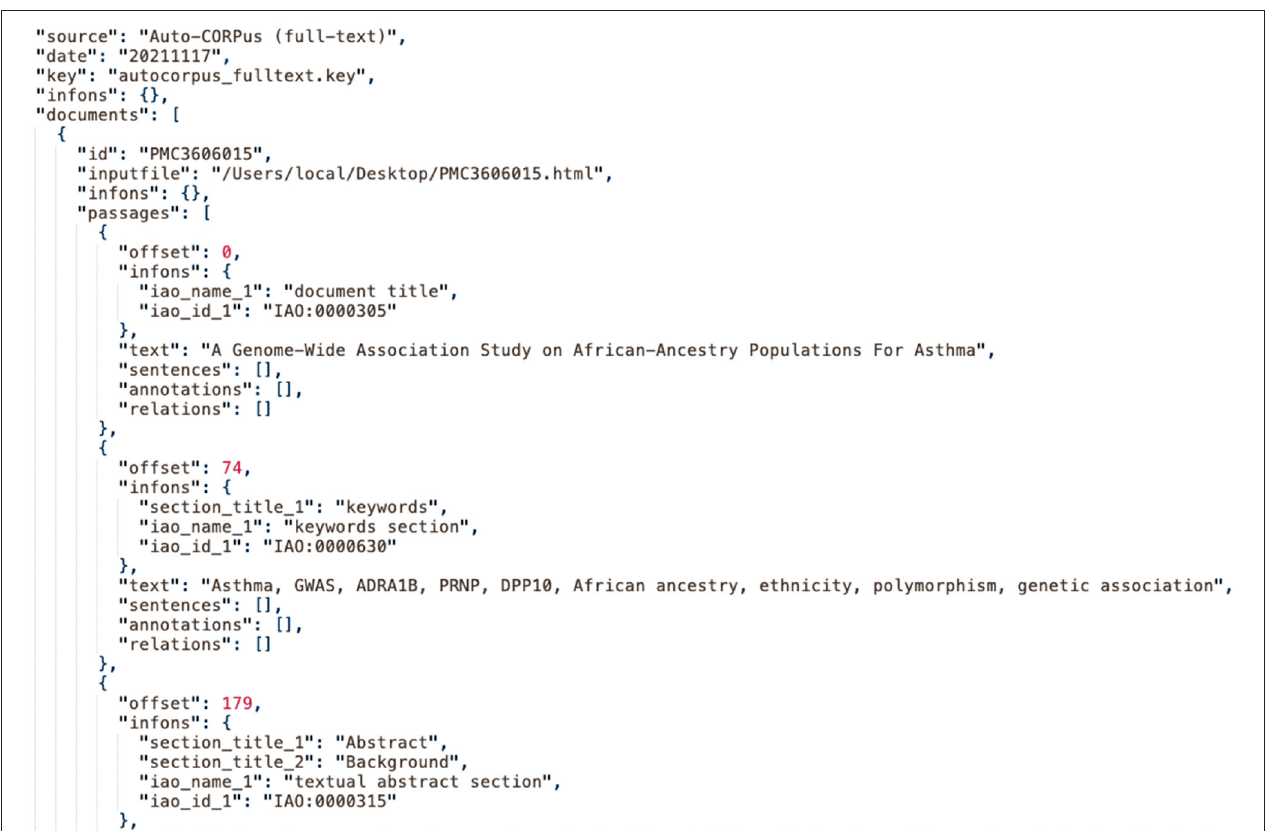
FIGURE 1 | An extract of the Auto-CORPus BioC JSON created from the PMC3606015 full-text HTML file. Each section is annotated with IAO terms. The “autocorpus_fulltext.key” file describes the contents of the full-text JSON file (https://github.com/omicsNLP/Auto-CORPus/blob/main/keyFiles/autocorpus_fulltext.